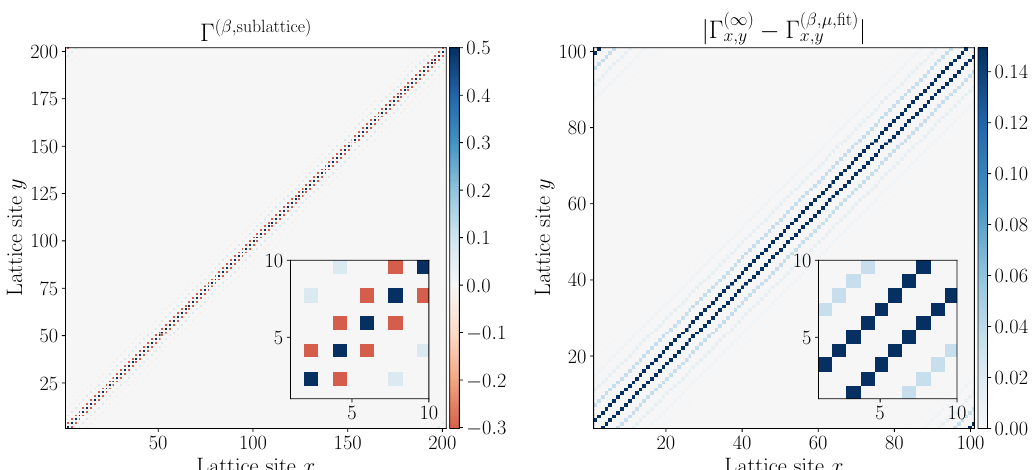
Figure 5: A system initially in a thermal state of the nearest-neighbour hopping Hamiltonian (left) on a sub-lattice can be quenched to translation invariant evo- lution which results in approximate translation invariance as one relaxes towards the steady state in finite time. The special initial condition results in the absence of nearest-neighbour currents on the whole lattice in the infinite time average (right). The best fit to a thermal state is given by an infinite temperature state with the corre- sponding filling ratio and strongly deviates from the steady state Γ ( ∞ ) . This is despite the density distribution becoming homogenous because the state deviates from the thermal ensemble by the absence of the nearest-neighbour current I (cid:48) and the pres- 1 ence of the next-nearest neighbour tunnelling I (cid:48) . Note that there are particles and 2 currents present on the initially unoccupied sub-lattice too. This showcases a general approach to creating initial conditions that demand a description in terms of a GGE by exploiting the existence of memory in terms of conserved local